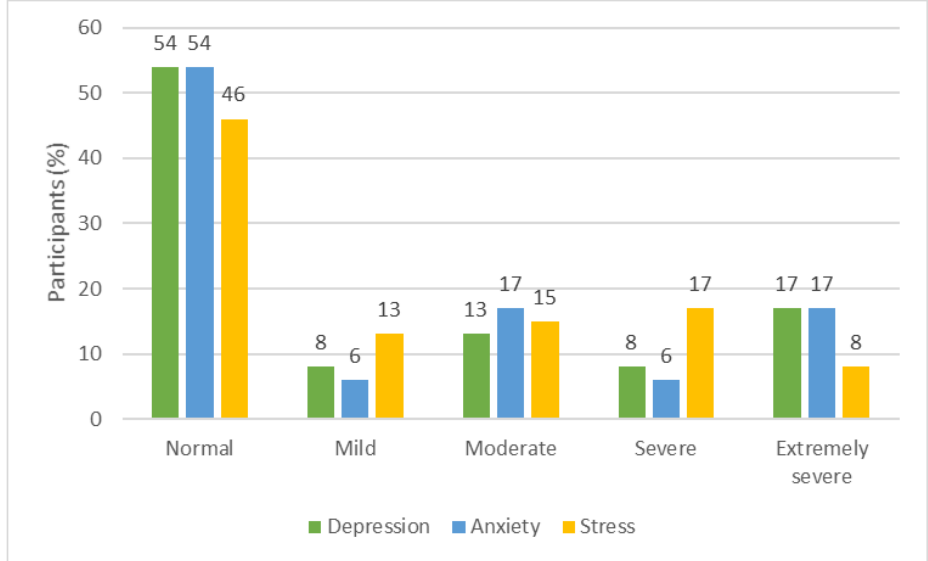
The Severity of Participants’ Depression, Anxiety, and Stress as Measured in the SDM by the